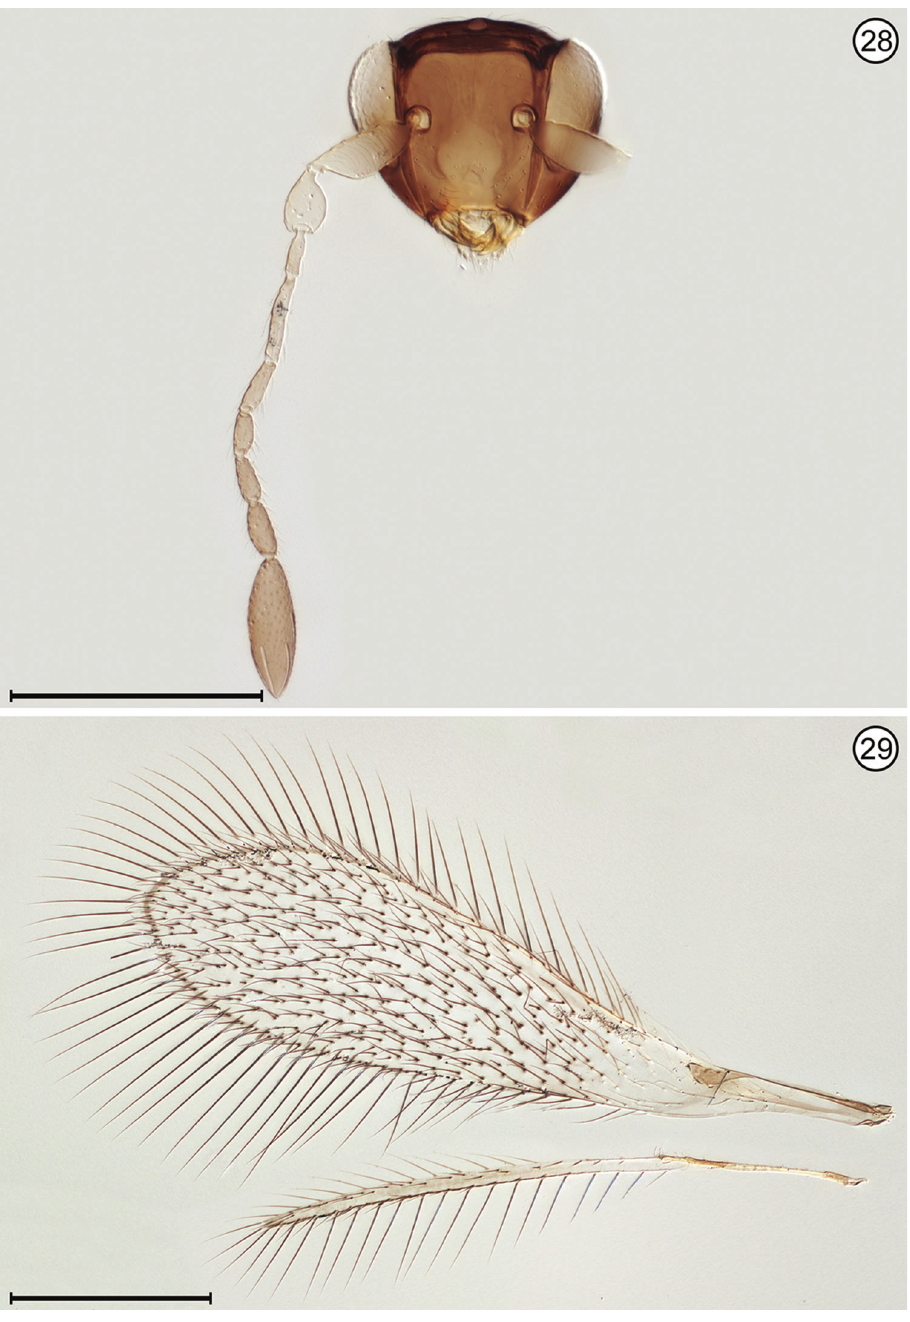
Figures 28, 29. Polynema sp., female 28 head, anterior + antenna 29 wings. Scale bars = 200